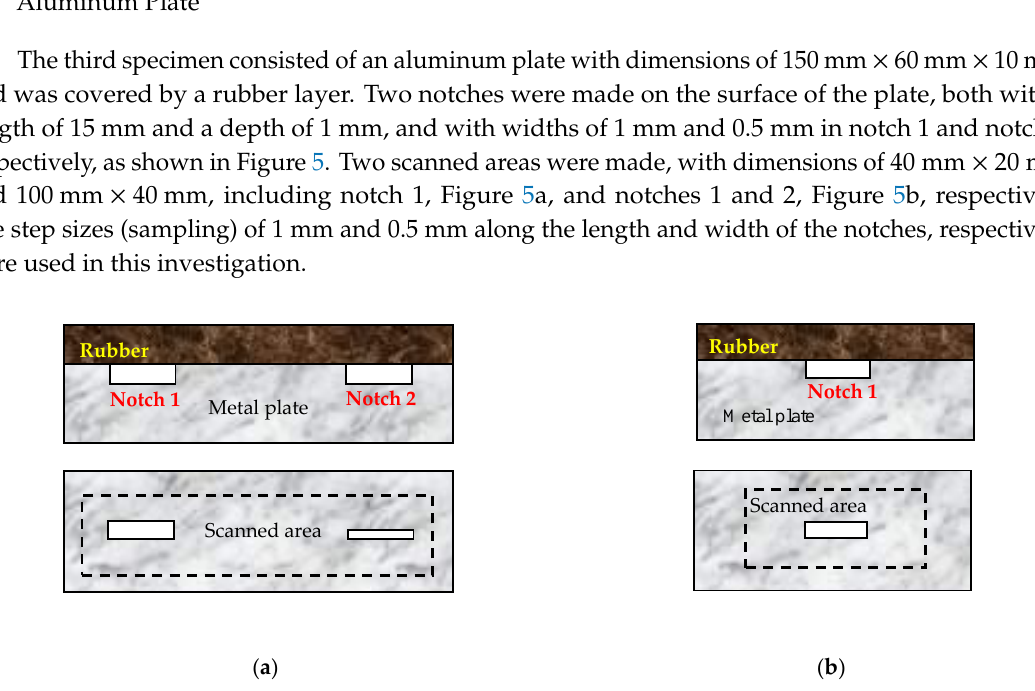
Figure 5. Cross-sectional side view (upper) and schematic of the top view without the rubber layer (lower) of the parts of aluminum plate with ( a ) notch 1 and ( b ) notches 1 and 2.